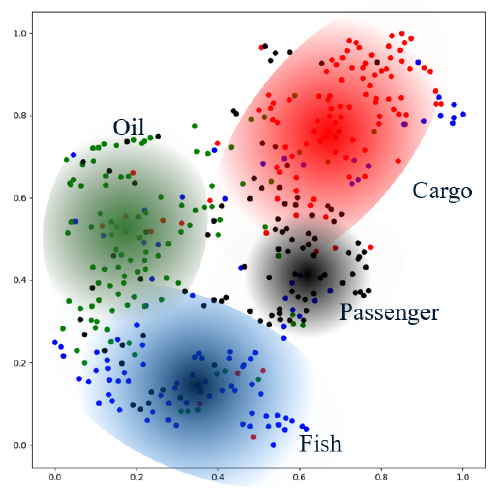
Figure 10. Ship movement embedding vectors visualization. The points shown in the figure are the high-dimensional vector points in the two-dimensional space after dimension reduction. These points are one-to-one corresponding to the original space’s ship movement, and the points with different colors represent different types of ships in the original space. We described the cluster and marked the specific the type of ship next to the